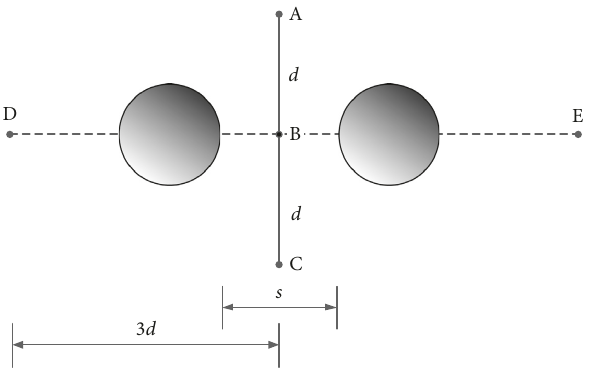
Figure 11: Five observation points.